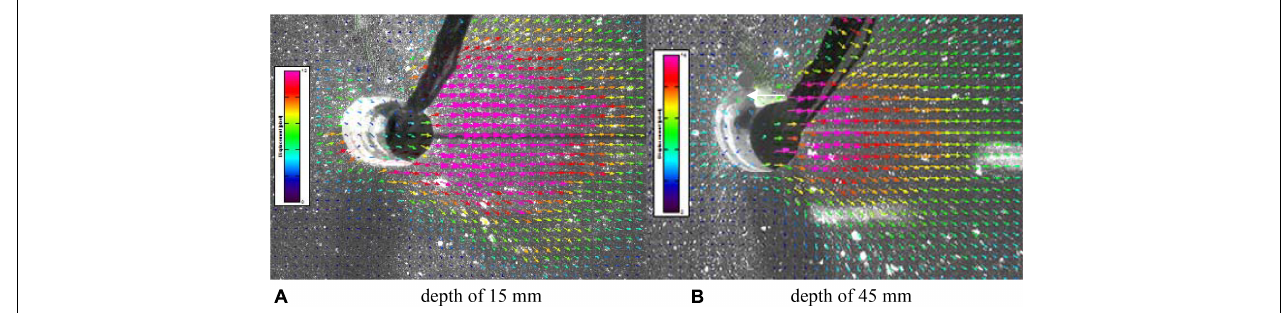
FIGURE 5 | Displacement vector of the soil around the pile at two depths. (A) Depth of 15 mm and (B) depth of 45 mm.